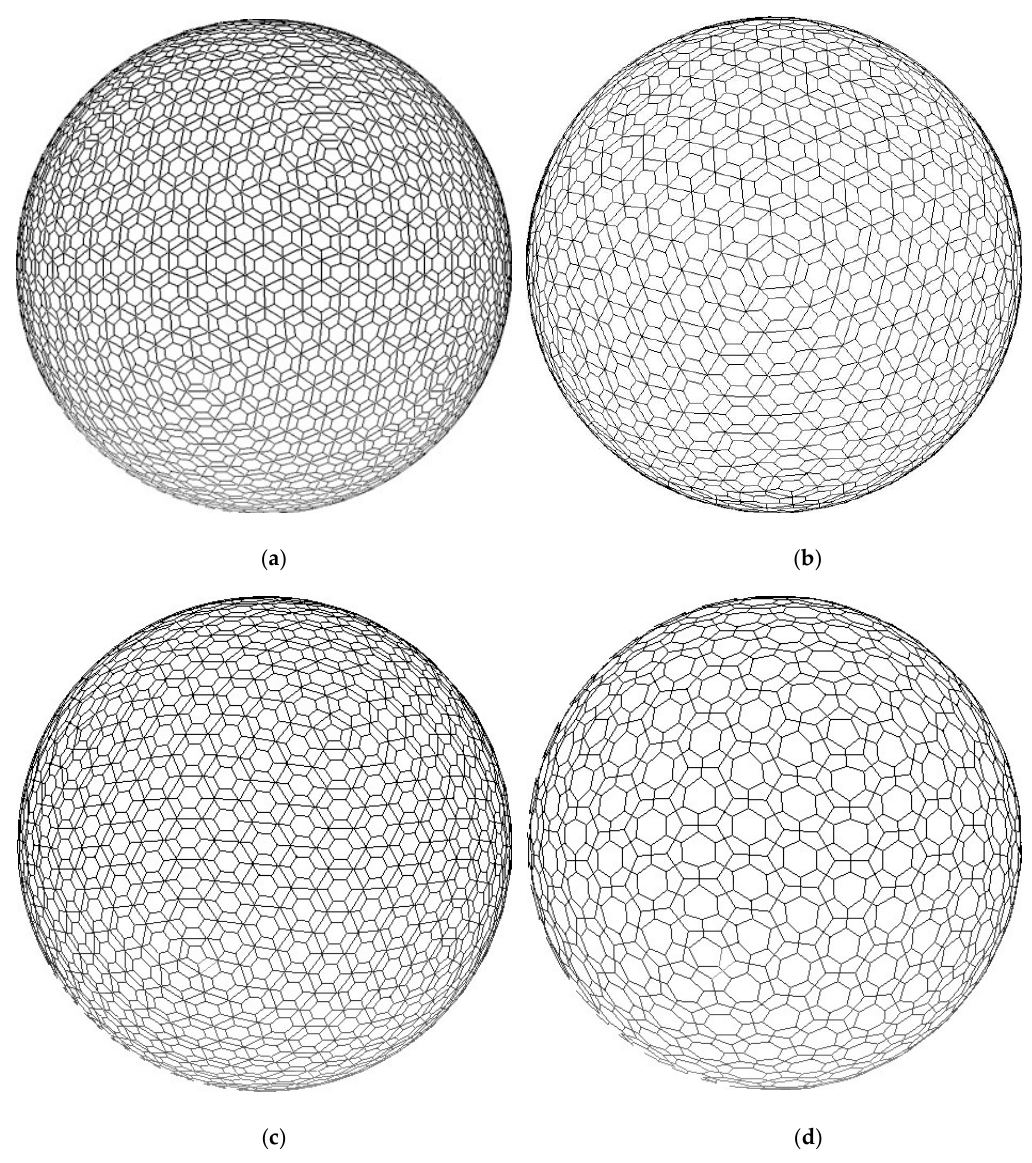
Figure 9. 4 types of hexagonal grid systems on the sphere. ( a ) Superposition of the 3rd and the 4th layers of the class I aperture 4 grid; ( b ) superposition of the 3rd and the 4th layers of the class II aperture 4 grid; ( c ) superposition of the 3rd and the 4th layers of the class III aperture 4 grid; and ( d ) superposition of the 3rd and the 4th layers of the aperture 3 grid.